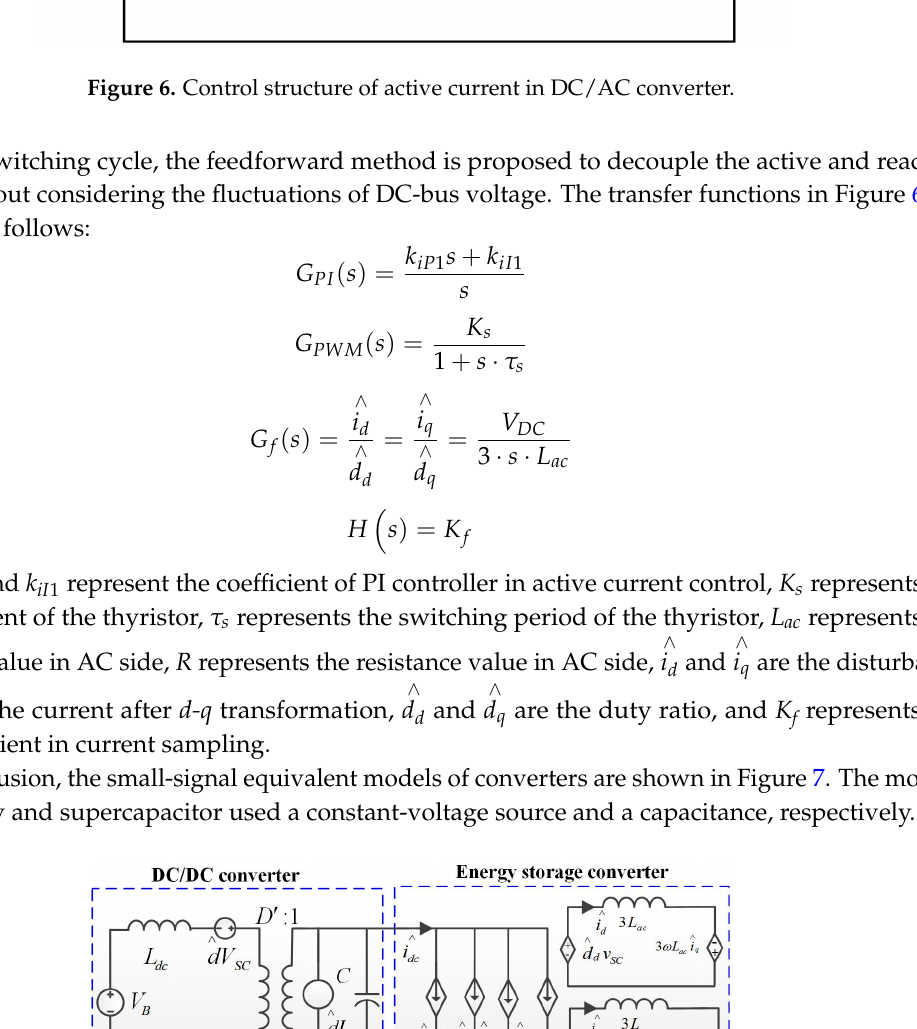
Figure 7. Small-signal equivalent model of converters.